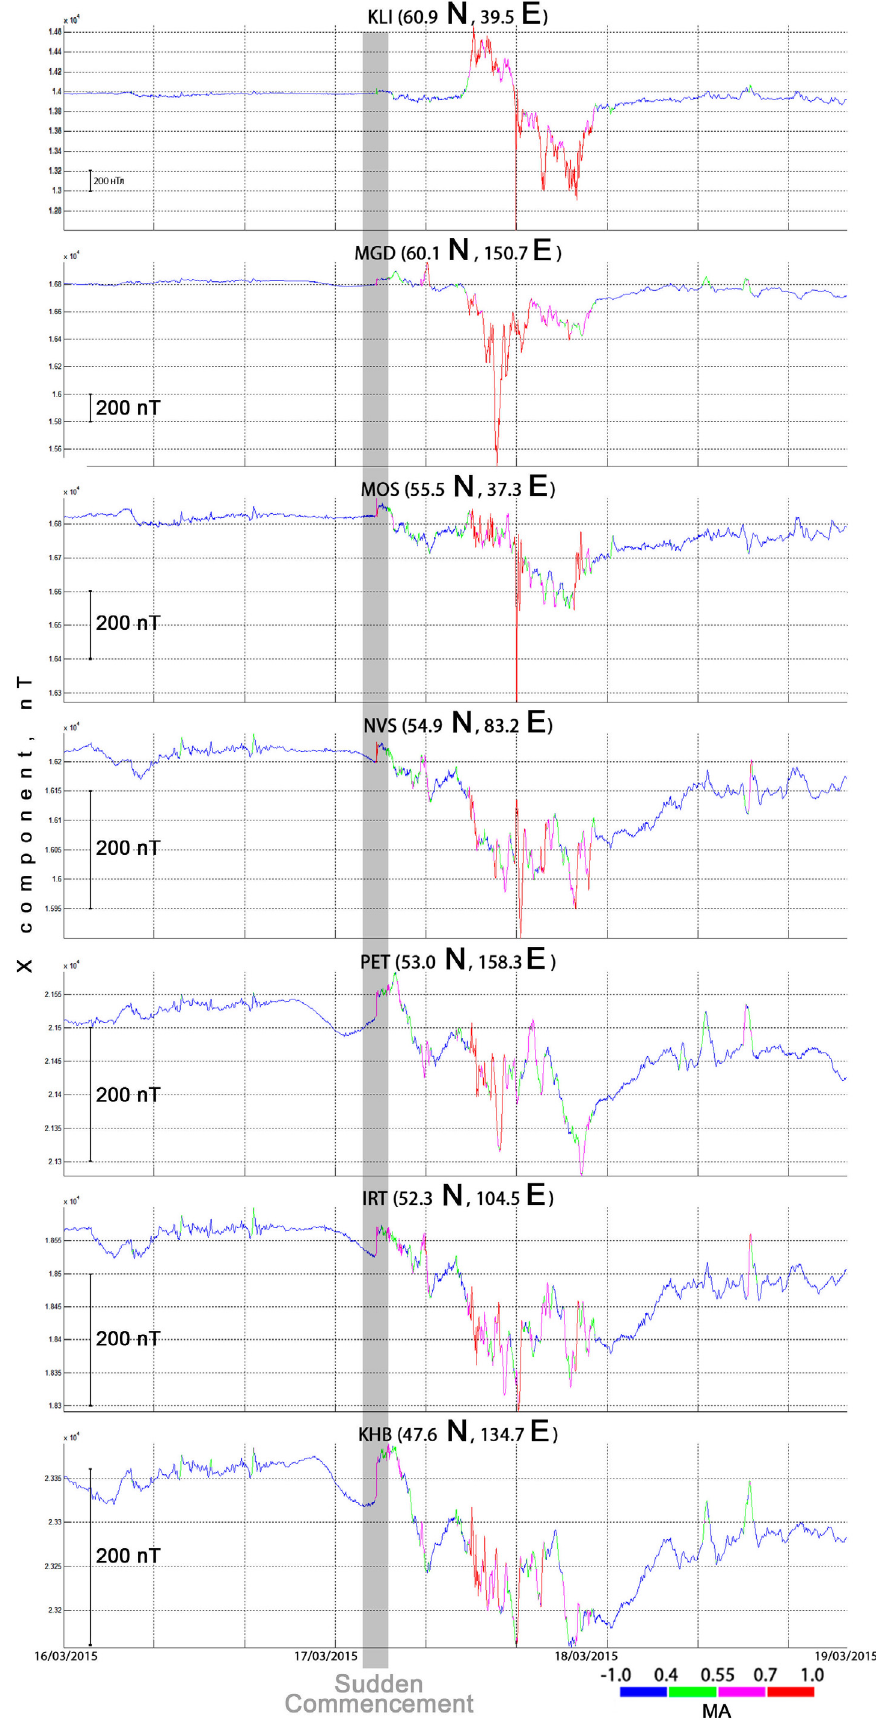
Figure 8. Simultaneous recognition of geomagnetic activity before, during and after geomagnetic storm on March 17, 2015, using data from Russian magnetic observatories. Time of the storm’s sudden commencement is indicated with grey strip. Date format: